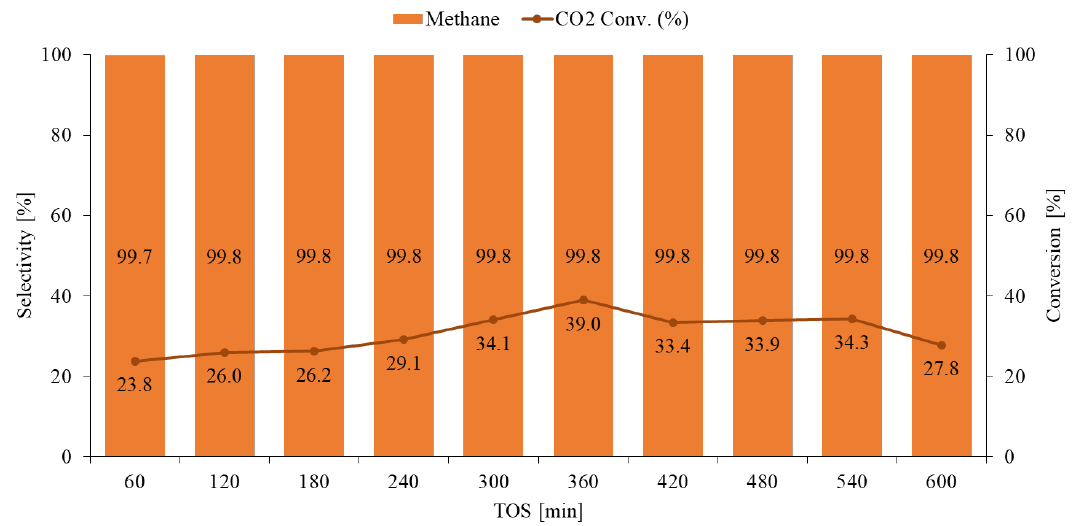
Figure 8. CoNi@C 0.2g, flow of mixture = 15 mL, mixture (H 2: CO 2 ) = 3:1, T = 375 °C, 30 bar.